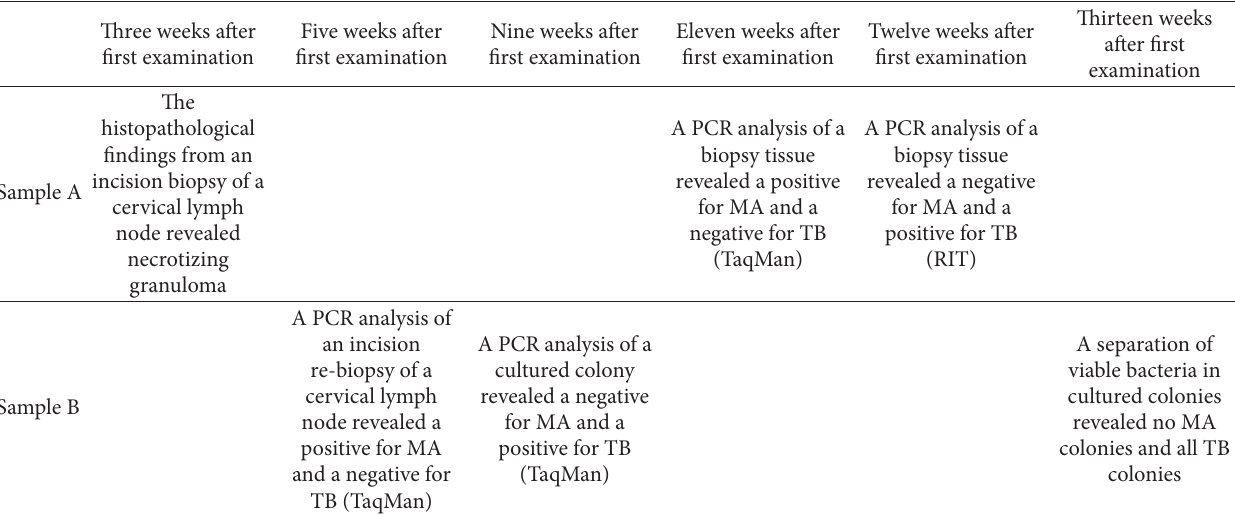
Table 2: Outline of microbiological